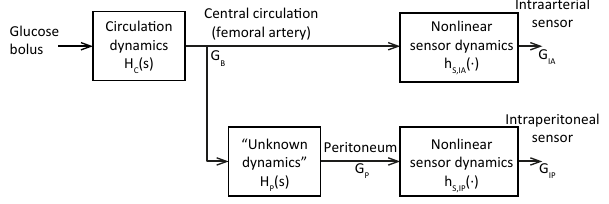
Figure 3: Model of glucose dynamics from infusion site to sensor sites, where G B ( t ) is the blood glu- cose concentration; G P ( t ) is the peritoneal fluid (or peritoneal lining) glucose concentra- tion; G IA ( t ) is the intraarterial (IA) sensor signal; G IP ( t ) is the intraperitoneal (IP) sen- sor signal; H C ( s ) is the circulation dynam- ics (from jugular vein to the femoral artery); H P ( s ) is the unknown physiological dynam- ics (from the femoral artery to the peritoneal sensor site); and h S , IA ( · ), h S , IP ( · ) are the non- linear sensor dynamics in IA and IP sensors, respectively. Copyright: CC BY-NC-SA